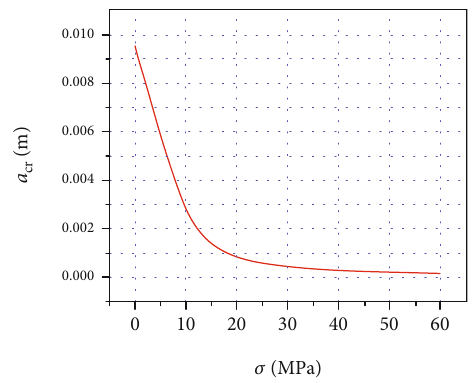
Figure 5: Relationship between the microcrack critical length and axial stress.